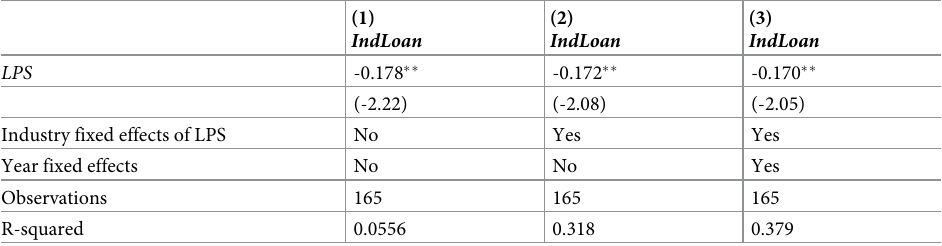
Table 3. The largest private shareholder and the industry’s NPL ratio. This table reports the estimation results from OLS regressions analyzing the impact of the largest private shareholder on the bank’s NPL ratio in their industry, with a different combination of fixed effects in each column. Columns 1–3 uses IndNPL as the dependent variable. Variables are defined in S1 Appendix. The sample period is from 2007 to 2020. In parentheses are t-statistics. ��� , �� , � indicate statistical significance at the 1%, 5%, and 10% level, respectively.